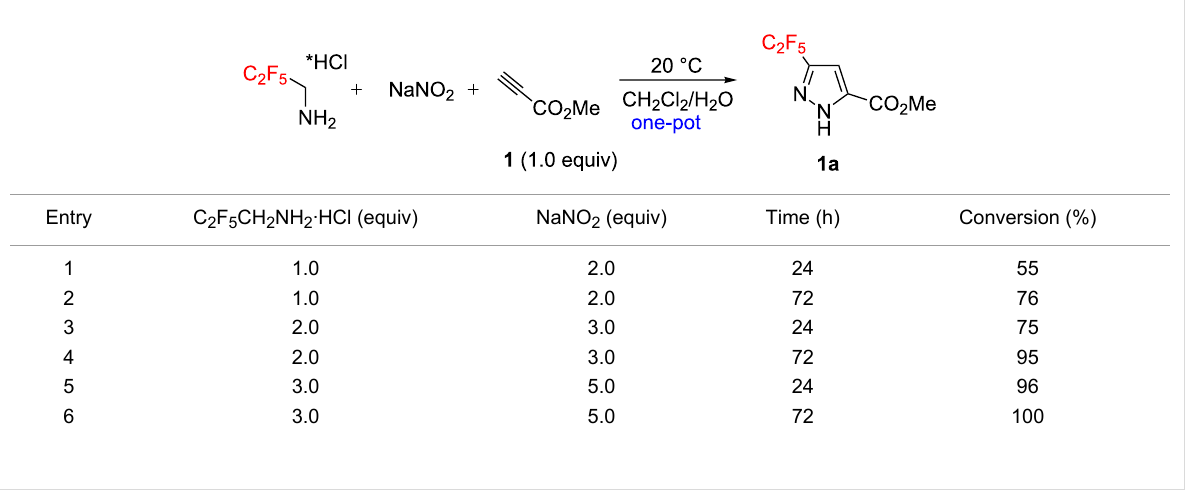
Table 1: Optimization of the reaction